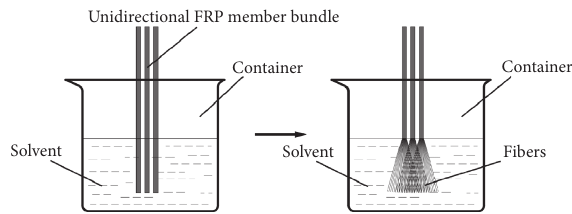
Figure 2: Dissolving the end of unidirectional FRP member